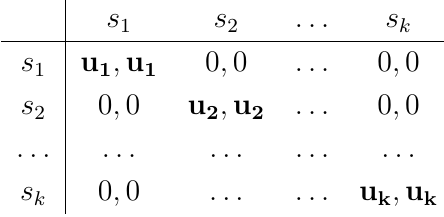
Table 2. A general payoff bi-matrix of a two-person pure coordination game. Nash equilibria in pure strategies are marked in